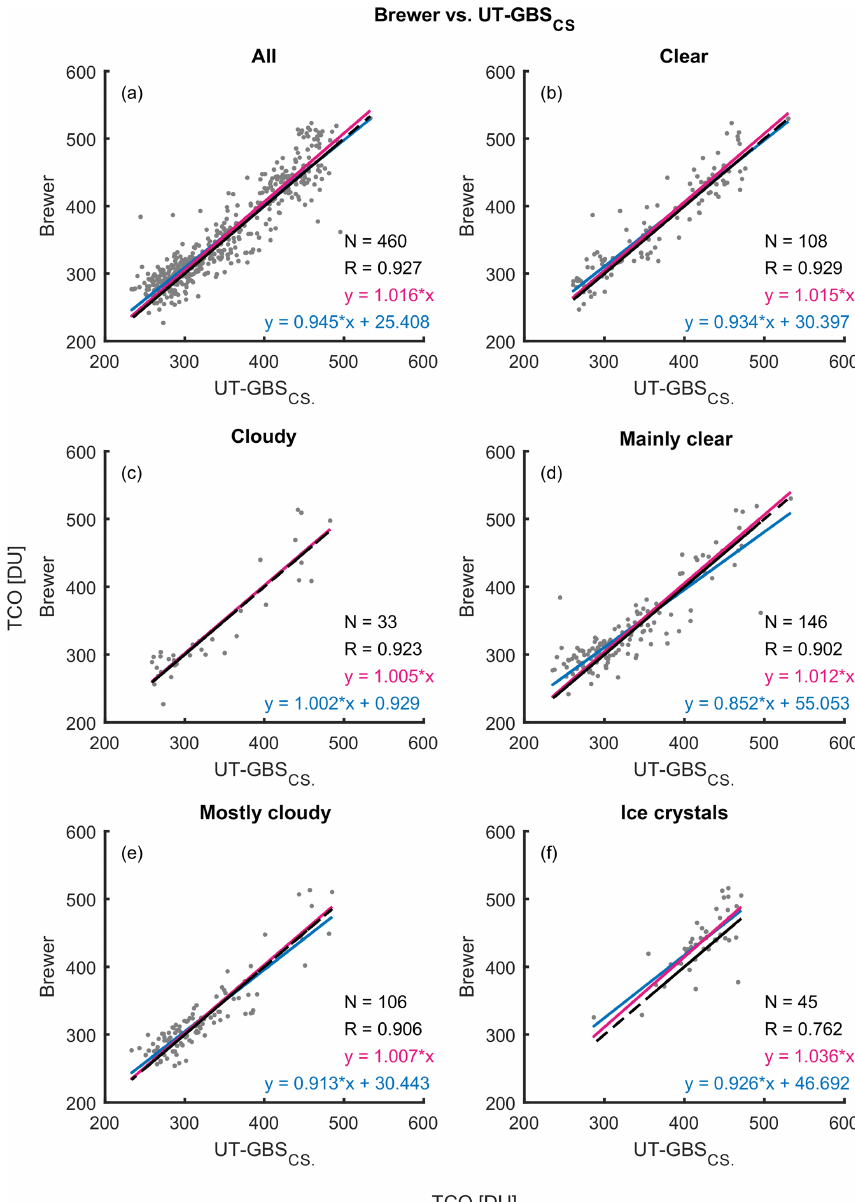
Figure 7. Scatter plots of Brewer total column ozone vs. UT-GBS cloud-screened TCO (UT-GBS CS ). Panel (a) shows the scatter plot of all coincident measurements of Brewer and UT-GBS CS . Panel (b) to (f) show scatter plots with weather conditions indicated in their titles. On each scatter plot, the red line is the linear fit with intercept set to 0, the blue line is a simple linear fit, and the black line is the one-to-one